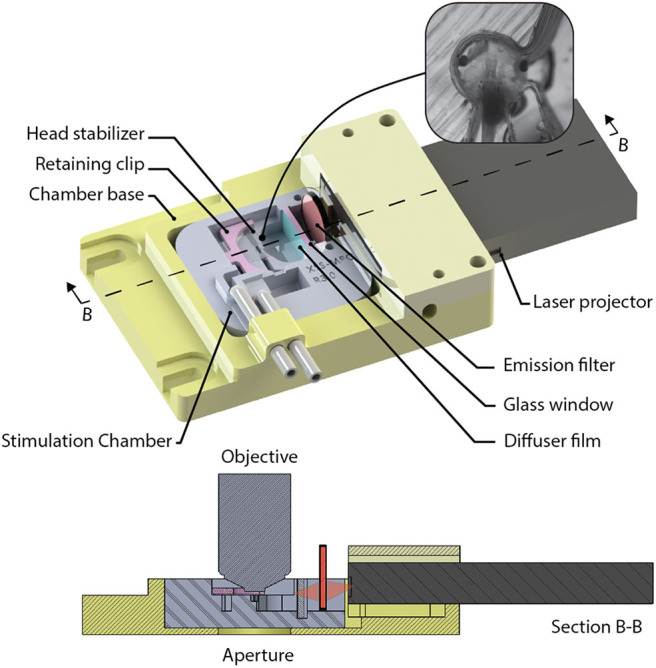
The visual stimulation chamber was designed to allow simultaneous imaging and visual stimulation by projecting red and black images to screen (diffuser film) using a laser projector (inset). The head of a tadpole is stabilized inside a small cavity that has an opening allowing the tadpoles eye to view the screen.